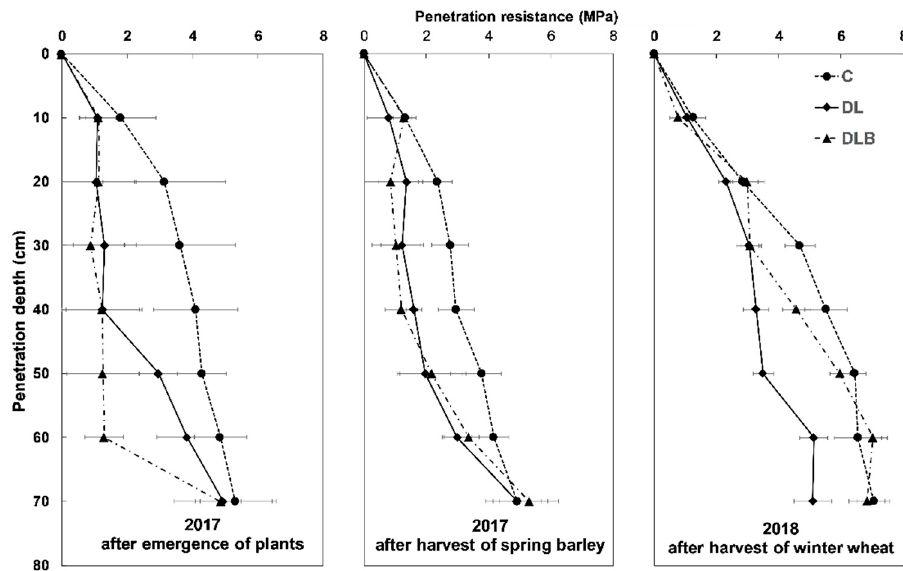
Figure 5. Measurements of penetration resistance. Measurements represent average values of n = 9 measurements. Error bars represent ± SD ( n = 9). C: control, DL: deep loosening with tine, DLB: deep loosening with tine and bio compost.